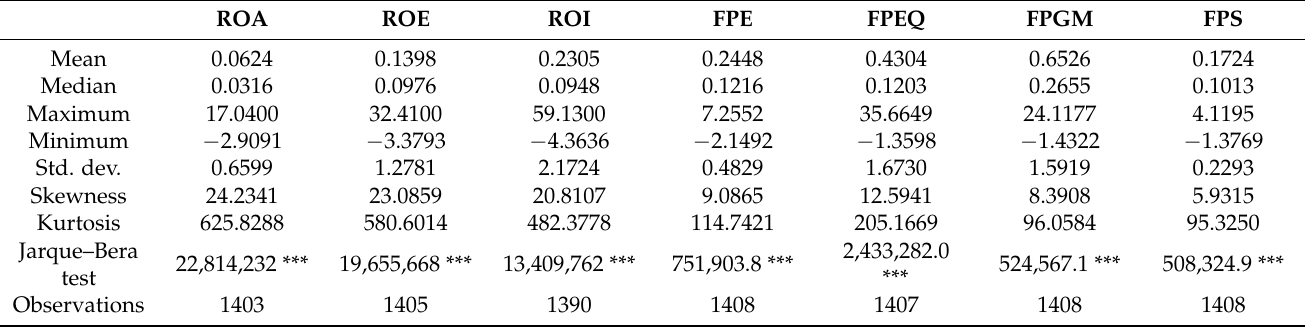
Table 4. Descriptive statistics of all energy